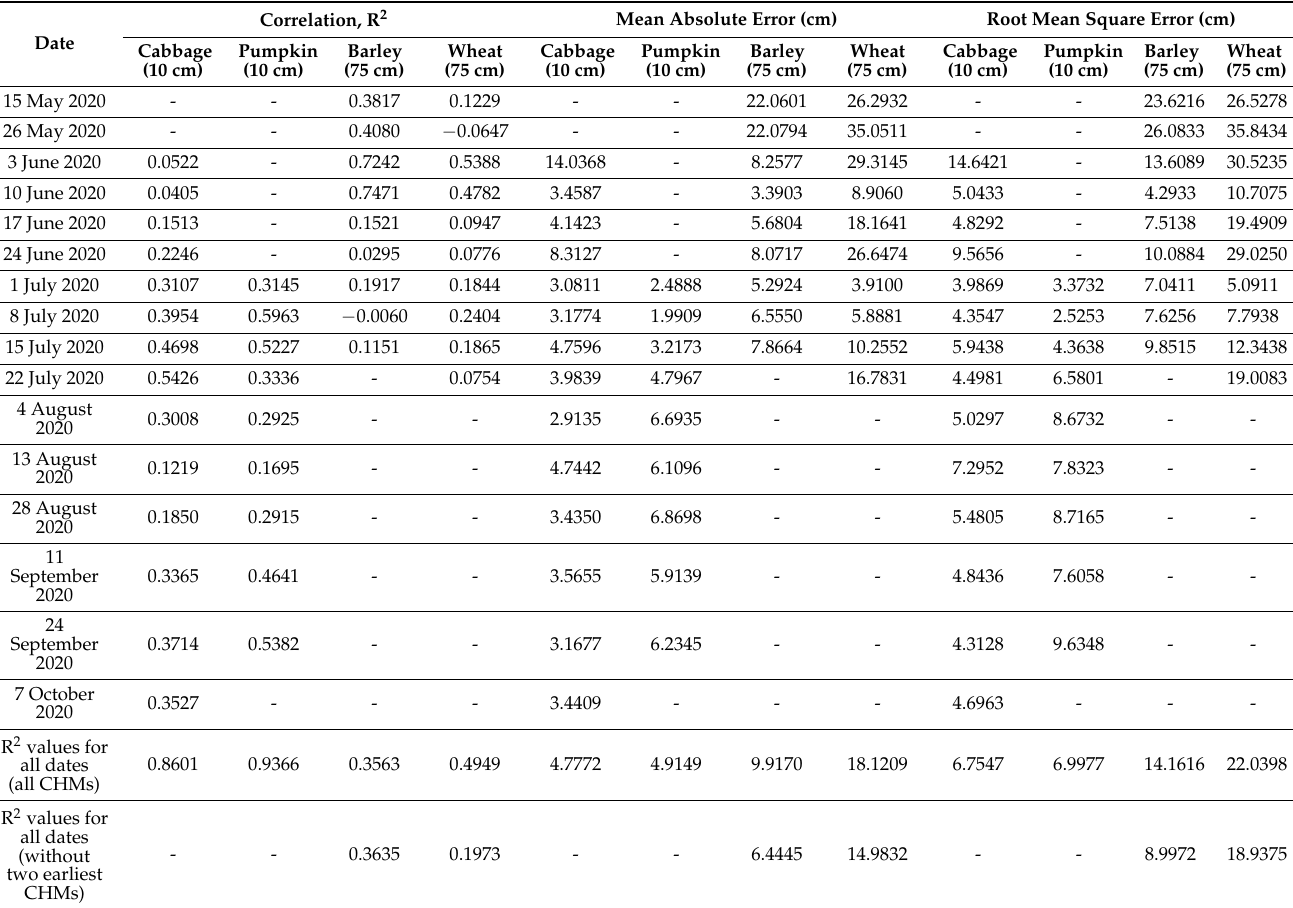
Table 4. Correlation (R 2 ), mean absolute error (MAE), and root mean square error (RMSE) for the relation between UAV-derived height estimation and field measurements for cabbage, pump- kin, barley, and wheat crops for all flight campaigns. Buffer sizes: cabbage—10 cm; pumpkin— 10 cm; barley—75 cm; wheat—75 cm. Percentiles: cabbage—100th; pumpkin—100th; barley—99th;